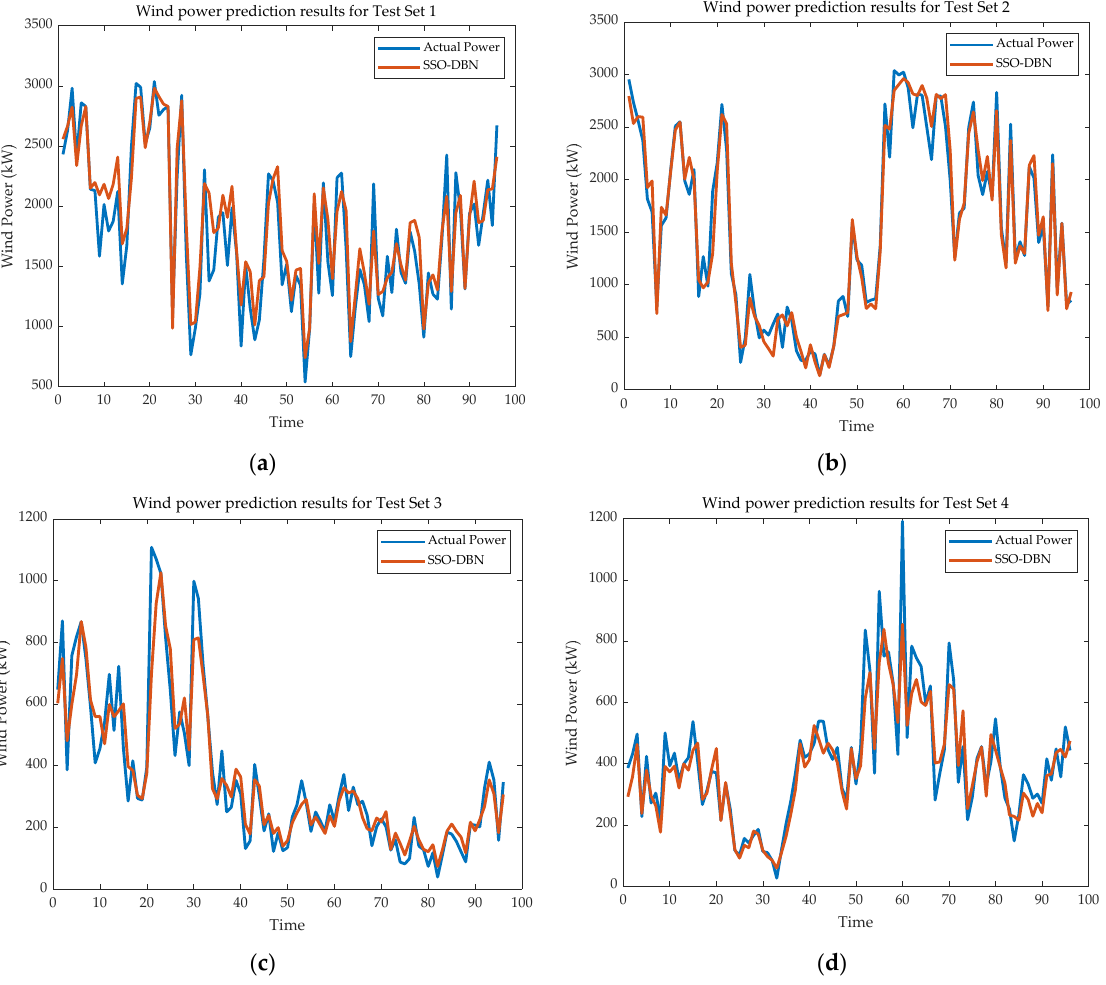
Figure 10. Predicted results of the proposed model for different test sets. Where, ( a ) is the result of set 1, ( b ) is the result of set 2, ( c ) is the result of set 3, and ( d ) is the result of set 4. Table 4. Prediction results of evaluation index (wind).